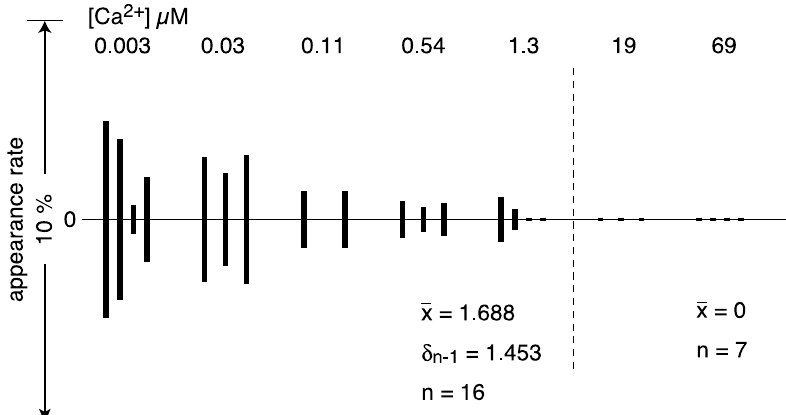
Figure 6. Percentage (%) of the number of tightly elongated vesicles with an ATPase crystalline array relative to the total number of vesicles in each of the four views recorded at the respective calcium concentration in the absence of ATP (see text for details). Vesicles with tetragon, two-rail or monomer crystals or a mixture of these crystal types, were included. Vesicles with crystalline arrays predominantly appeared at ~1.3 µ M Ca 2+ or less.